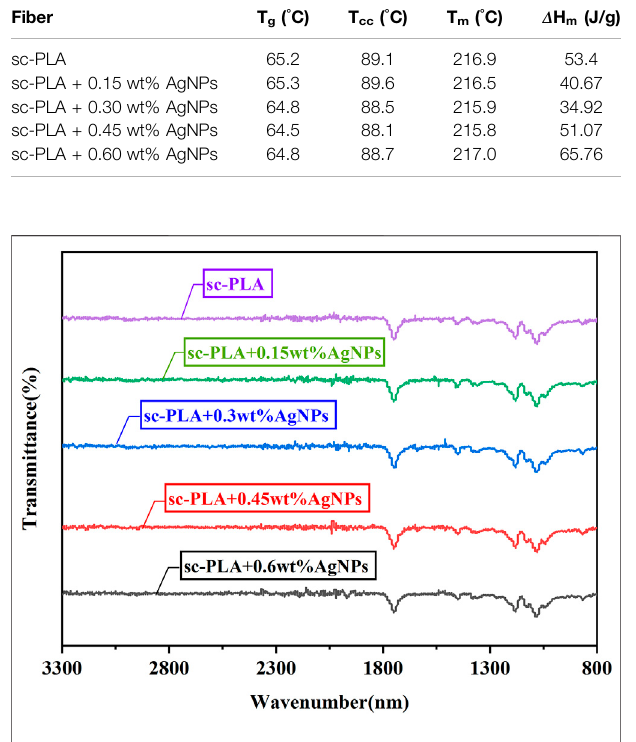
FIGURE 7 | FTIR curves of sc-PLA electrospun membranes with different AgNP